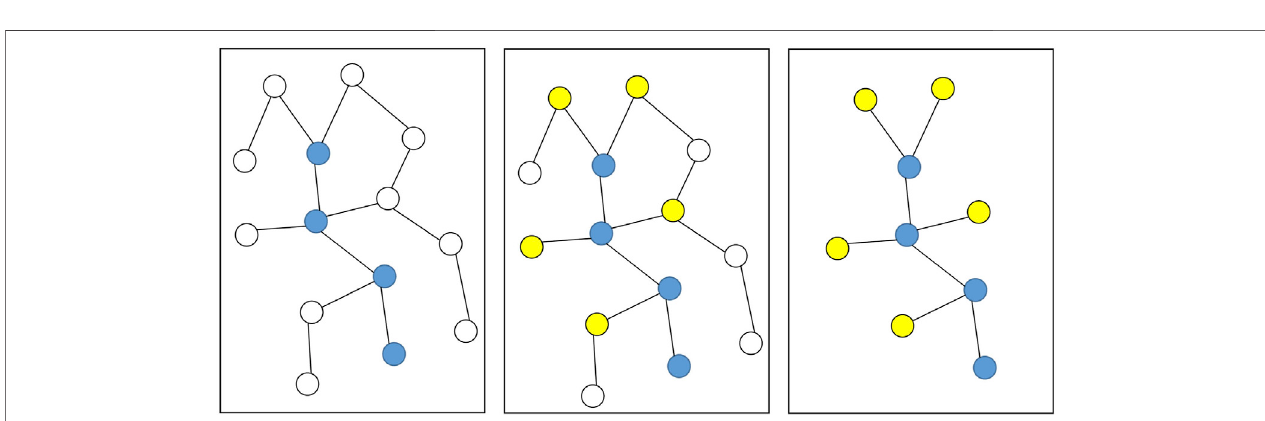
FIGURE 3 | An example of users sampling method. Blue nodes is observed users. Yellow nodes is what we select.